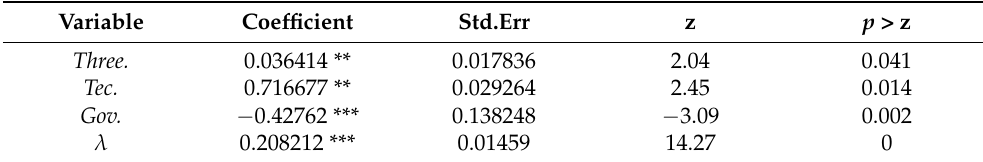
Table 4. Regression results of the influencing factors of the MSW treatment carbon emission efficiency in China. Variable Coefficient Std.Err z p > z